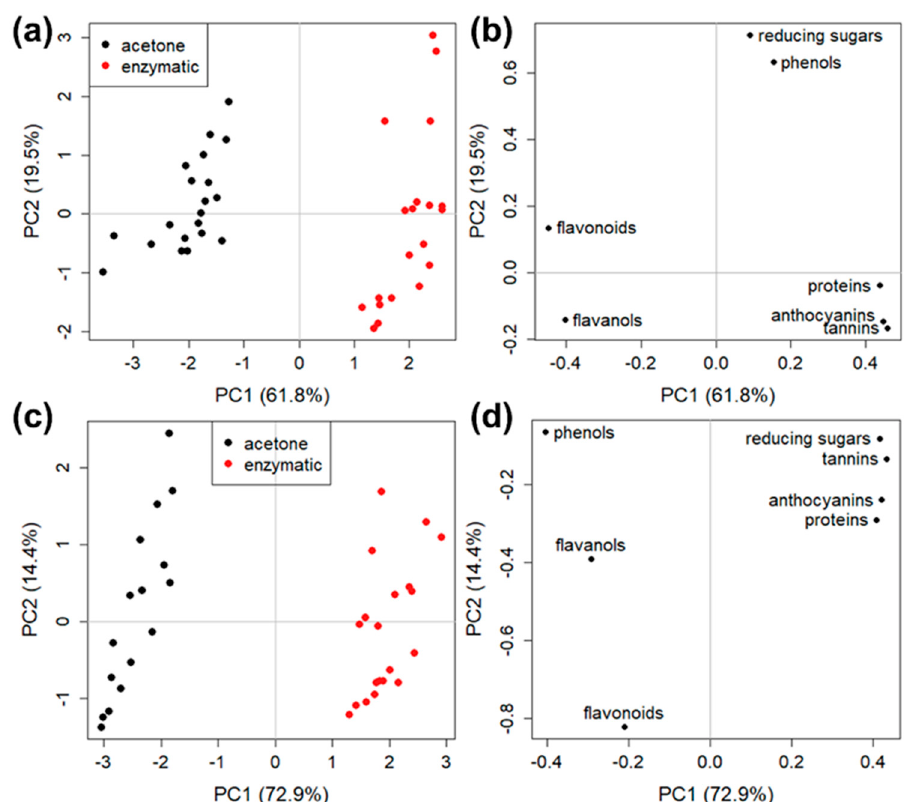
Figure 4. PCA models for ( a , b ) Merlot GP and ( c , d ) Garganega GP in enzymatic (red points) and acetone (black points) samples; ( a , c ) score plots and ( b , d ) loading plots.